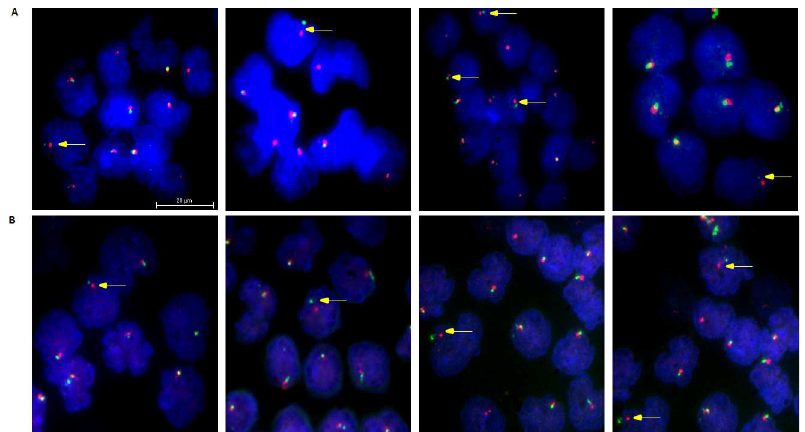
Fig 2. Representative images of CTCs from metastatic ASPS patients. (A-B) Specimens were probed with a two-color(green and red) probe set (for additional details, see Online Methods) and counterstained with DAPI. Co-localization of the probes (visualizedas a yellow signal), indicatesa normalXp11.2 locus. Yellow arrowheads denote cells with TFE3 rearrangements (separate green and red signals),which identify CTCs characterized by the separationof the probes. Scale bars indicate 20 μ